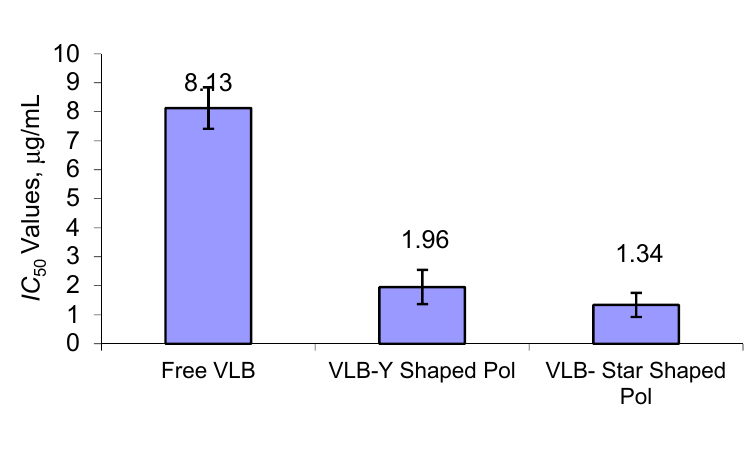
Figure 16. IC values of two polymeric formulations of Vinorelbine in 72 h compared to 50 free